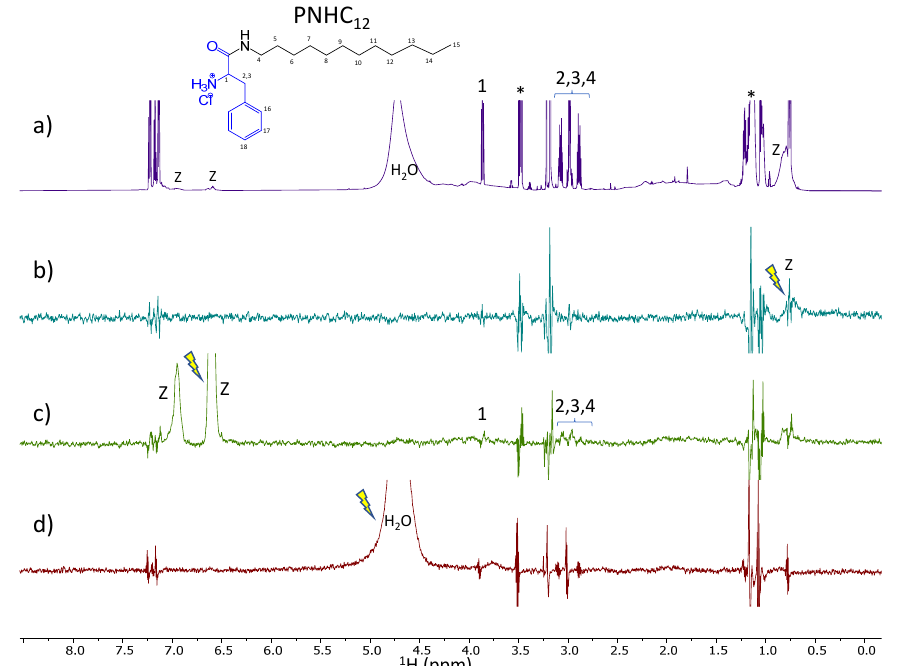
Figure 7. Spectra of PNHC 12 and zein mixture. ( a ) 1 H NMR, ( b , c ) STD off-on spectra with saturation at 0.82 and 6.6 ppm, respectively and ( d ) WaterLOGSY (mix. 500 ms). The arrow indicates the signal that is selectively on-saturated in STD spectra or selectively inverted in WaterLOGSY. The assignment is provided for some relevant protons giving STD or waterLOGSY responses. The z refers to zein peaks and the asterisk denotes protons of ethanol impurity.